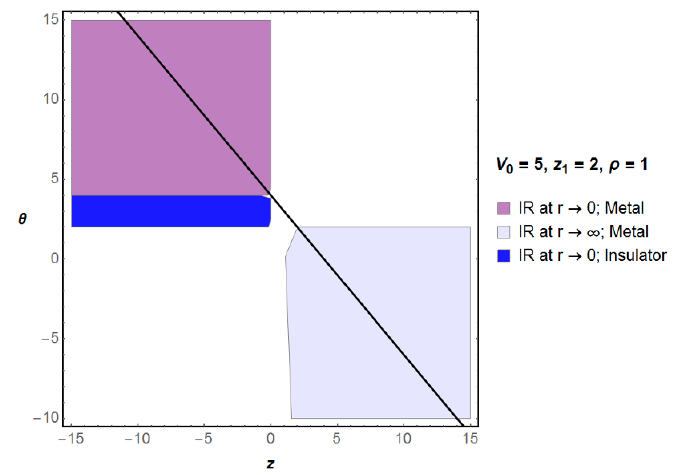
Figure 5 . The shaded areas denote the allowed ranges of z and (cid:18) after taking into account all constraints on the theory parameter space. This case corresponds to V 0 = 5 ; z 1 = 2 ; (cid:26) = 1. The straight line (cid:18) = 4 (cid:0) z corresponds to a resistivity linear in temperature, which for these parameters is allowed in much of the phase space.